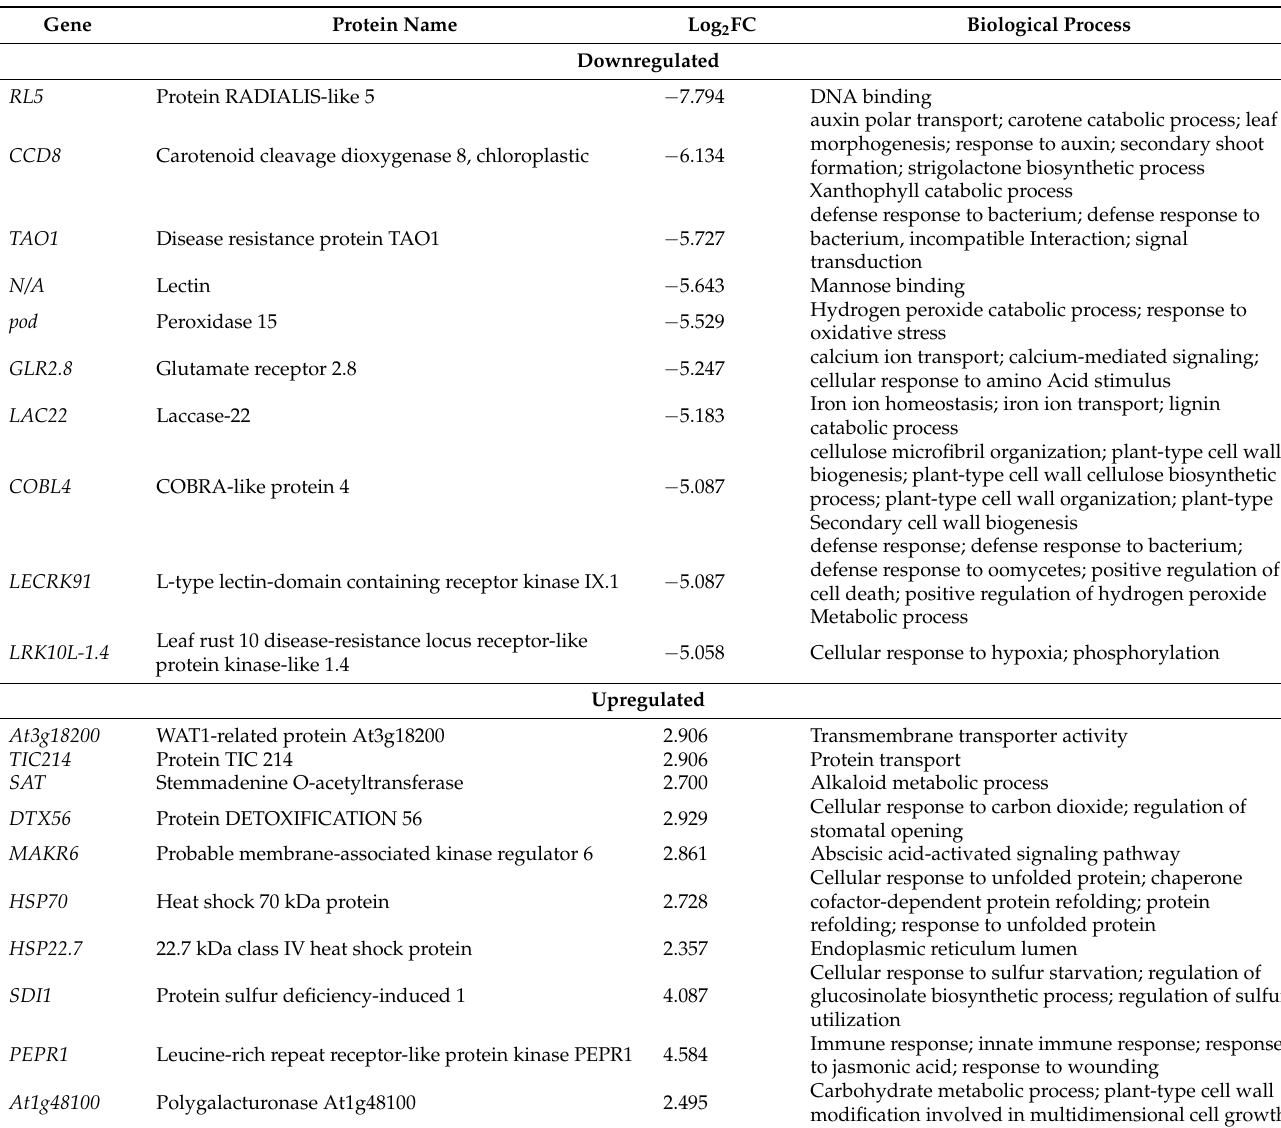
Table 5. Top 10 most down and upregulated differentially expressed genes (DEGs) in Casuarina glauca nodulated by nitrogen-fixing Frankia casuarinae Thr (NOD + ), grown at 600 mM NaCl relative to the control (0 mM NaCl), ordered by log2 fold-change (log2FC). NBCI gene symbol, protein name, log2FC and respective Gene Ontology (GO) molecular function(s) and biological process(es) retrieved from UniprotKB database. Protein names coloured in blue are also among the top 10 most down or upregulated DEGs, respectively, at 600 mM NaCl in non-nodulated plants supplied with KNO 3 (KNO 3+